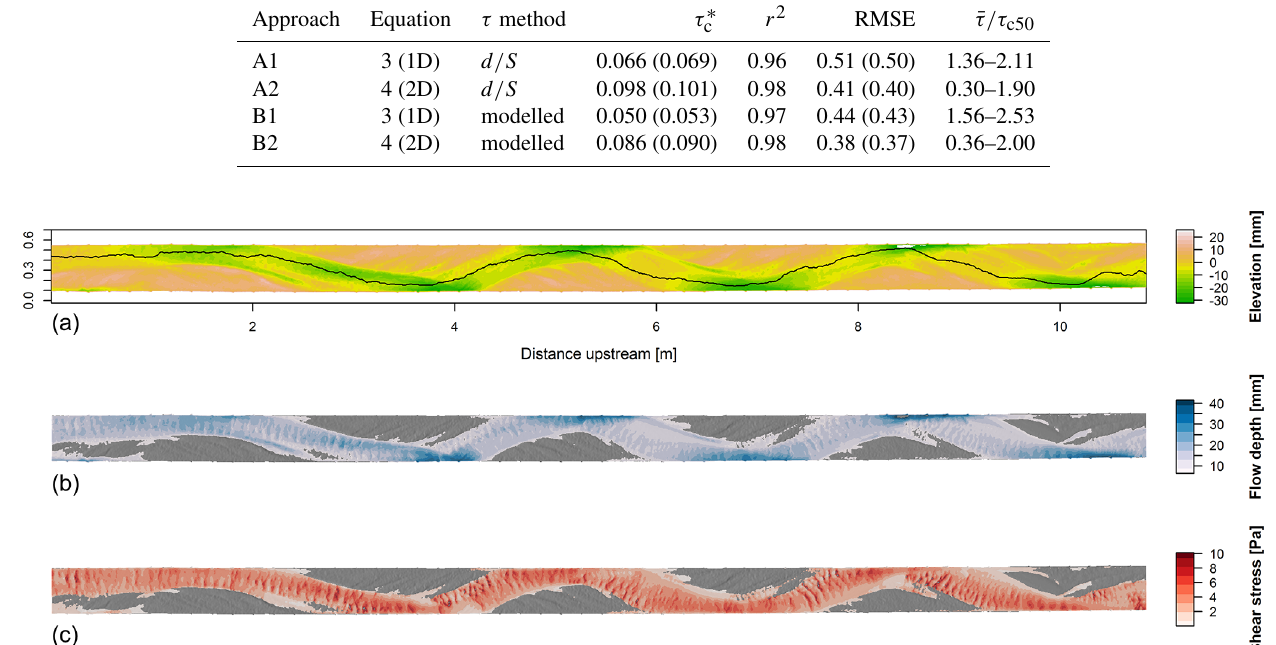
Figure 5. Channel area at the conclusion of experiment 3b ( W = 0 . 45m, ¯ τ = 2 . 41Pa) displaying the following characteristics (a–c) : (a) el- evation, (b) flow depth, and (c) shear stress from the flow model. Cells where d < 2 D 84 are not shown. A transect along the path of the highest bed shear stress is displayed as a black